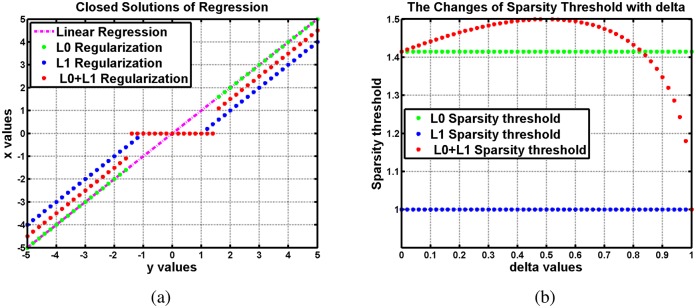
Analysis about combination of L1 and L0 regularization.(a) shows the closed solutions of linear regression, L0, L1, L0 + L1 regularized regression, respectively. (b) shows the sparsity threshold changes of L0, L1 and L0 + L1 regularized regression, respectively.